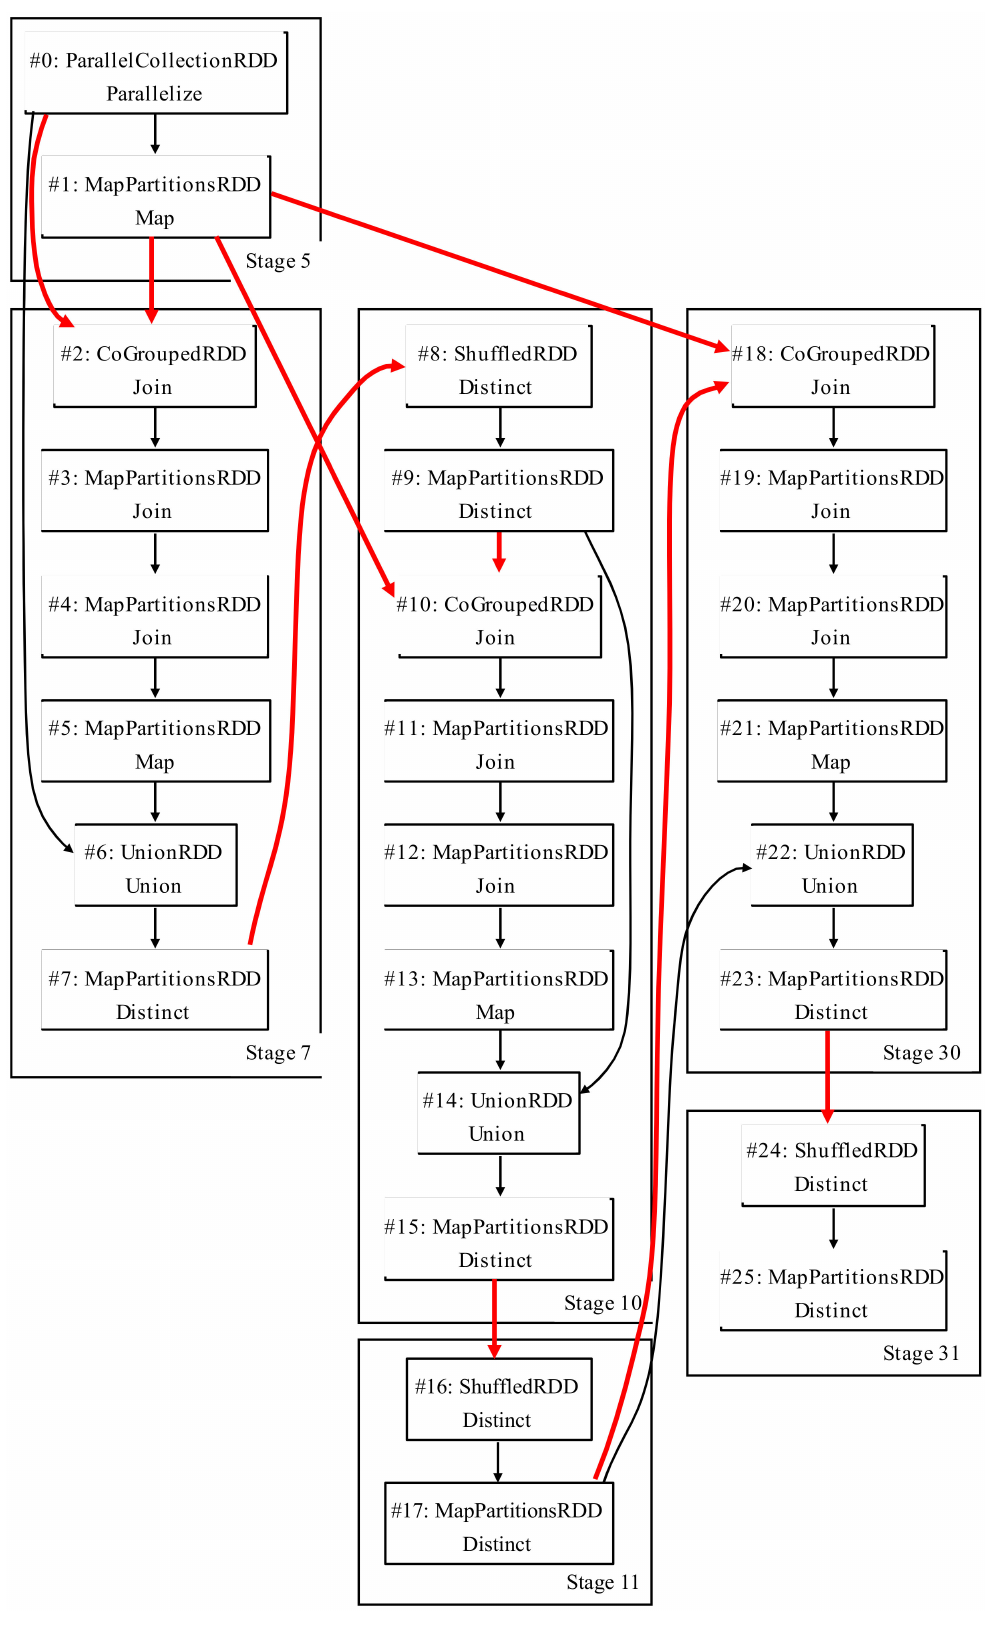
Figure 3. RDD flow of a profiled SparkTC